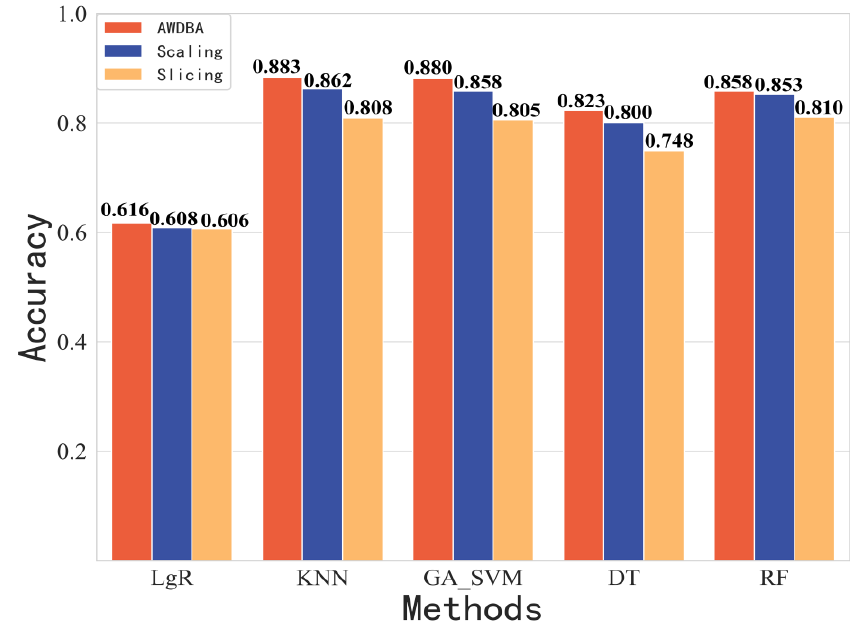
Figure 10. Accuracy of other data augmentation techniques compared with that of AWDBA.